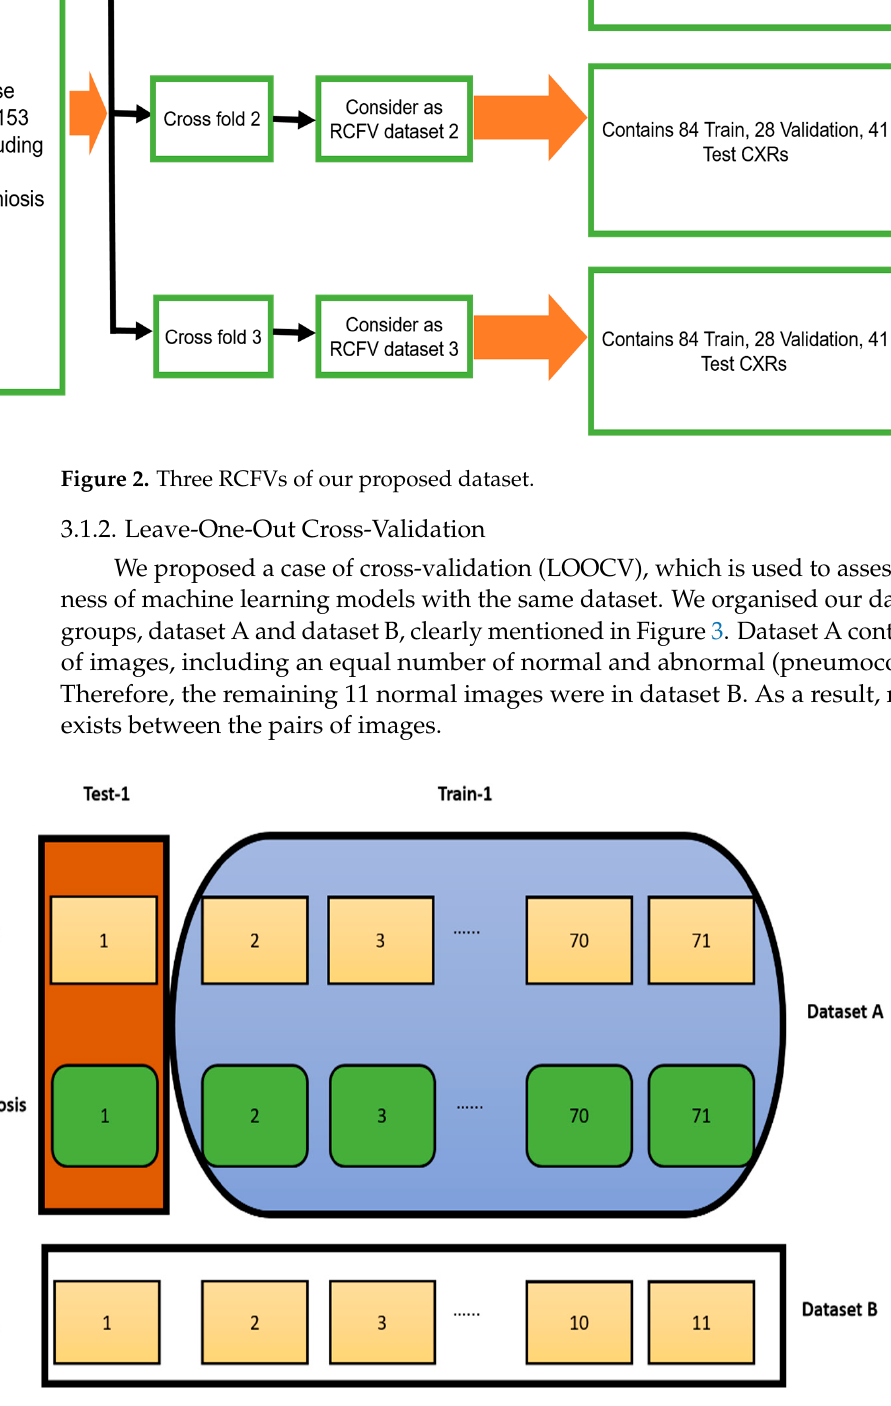
Figure 3. Data orientation for LOOCV implementation .